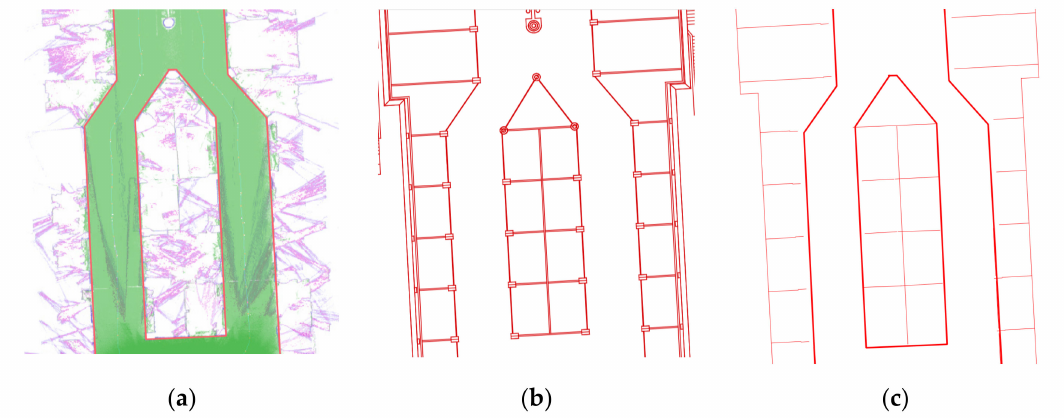
Figure 4. Construction of topographic information for each store using point cloud data. ( a ) Point cloud vectorization. ( b ) Determination of occupancy status by store. ( c ) Final determined